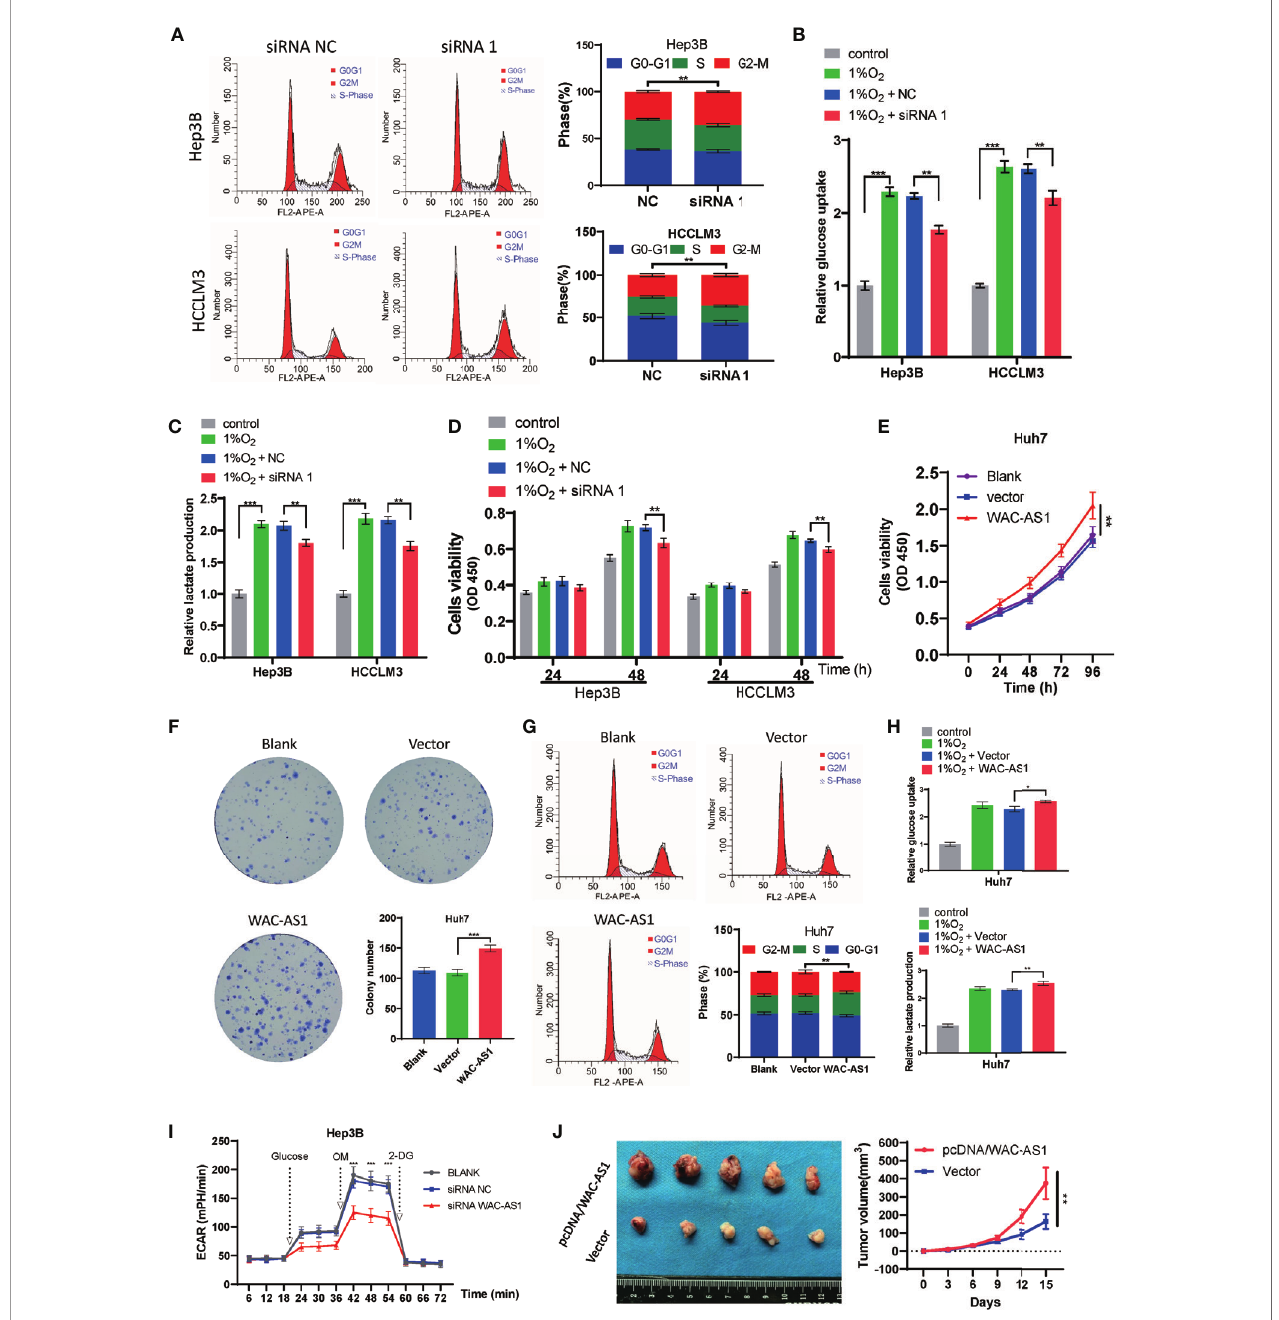
FIGURE 6 | The effect of WAC-AS1 on glycolysis and the cell cycle. (A) cell cycle analysis was used to detect the cell cycle distribution after transfection; (B) glucose uptake in Hep3B and HCCLM3 cells; (C) lactate production detected by the lactate assay kit; (D) CCK-8 assay for cell viability; (E) cell viability of Huh7 cells after overexpression of WAC-AS1; (F) representative images of plate colony formation in Huh7 cells; (G) cell cycle analysis of Huh7 cells; (H) glucose uptake and lactate production in Huh7 cells; (I) ECAR levels in Hep3B cells; (J) subcutaneous xenograft tumors and growth curve. ∗ P < 0.05; ∗∗ P < 0.01; ***p <